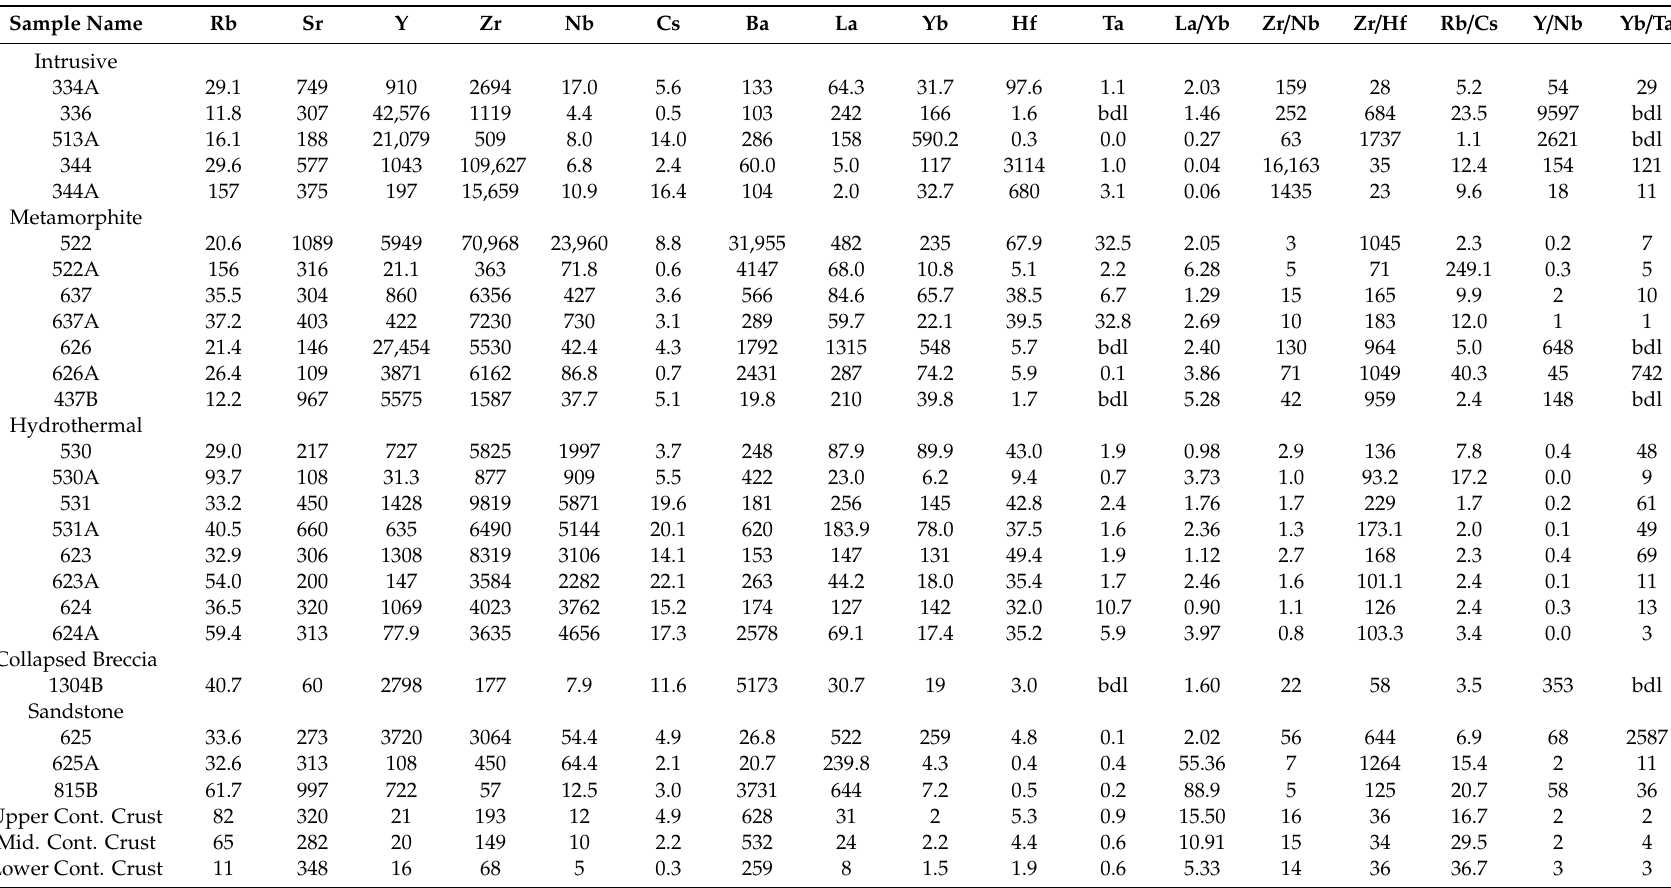
Table 2. Trace element abundances (ppm) determined by solution mode (SM) inductively coupled plasma mass spectrometry